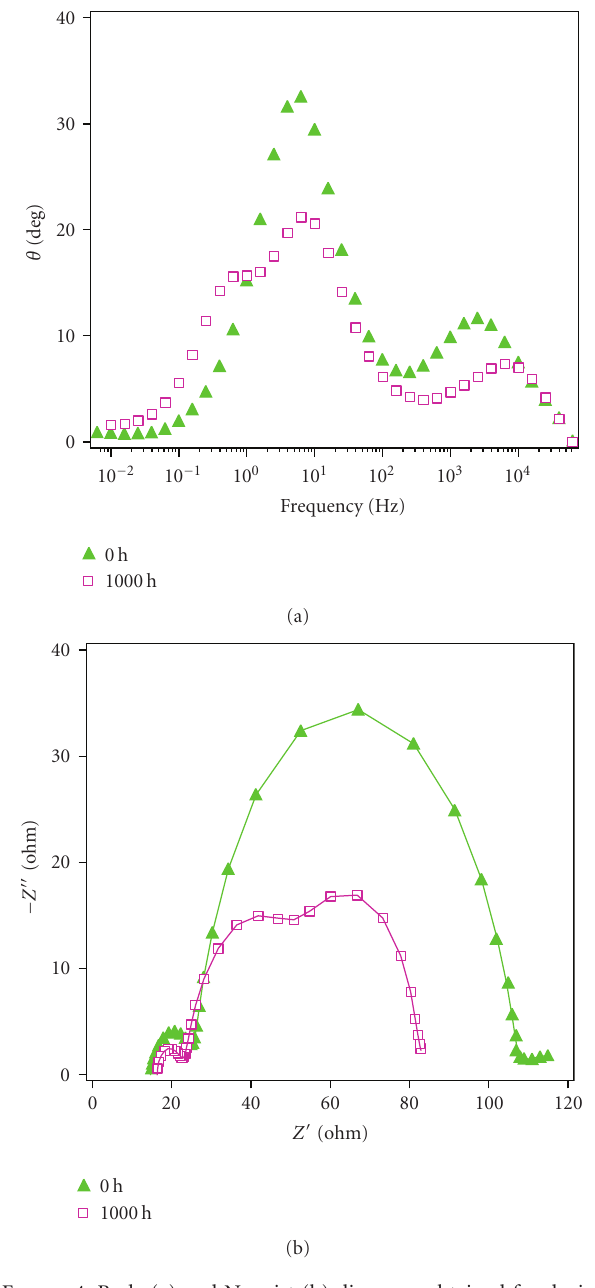
Figure 4: Bode (a) and Nyquist (b) diagrams obtained for device A before and after 1000 hours under thermal/light soaking stress. In the Nyquist diagram, symbols correspond to the impedance data obtained experimentally in the dark under − 0.75 V bias, while solid lines represent the fittings according to the equivalent circuit present in Figure 5.